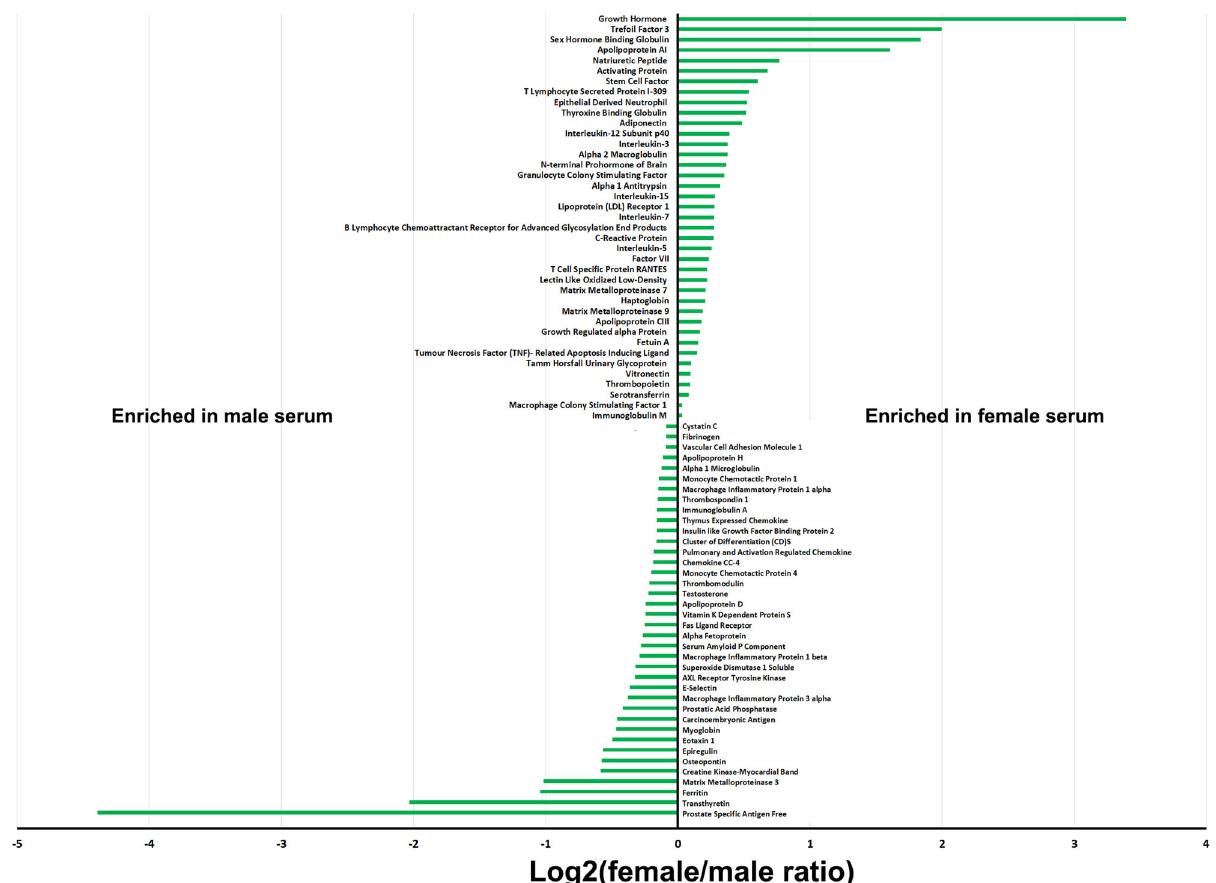
Fig. 2 Molecular sex differences in human serum. Log2-scale of female to male serum concentration ratio of 77 analytes (out of 174 identi fi ed serum molecules across nine independent cohorts of individuals consisting 196 males and 196 females) that had signi fi cant differences in male and female serum concentrations (data for the graph was extracted from reference 44